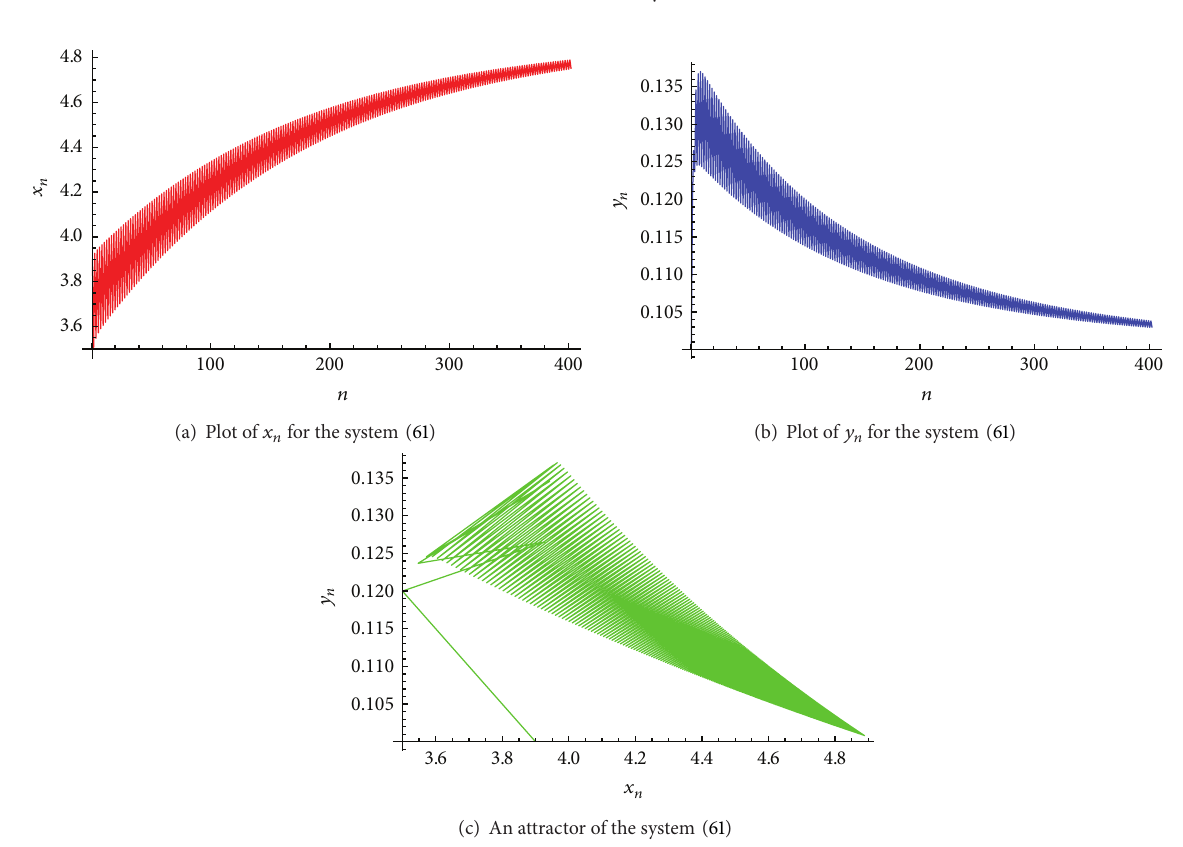
Figure 3: Plots for the system